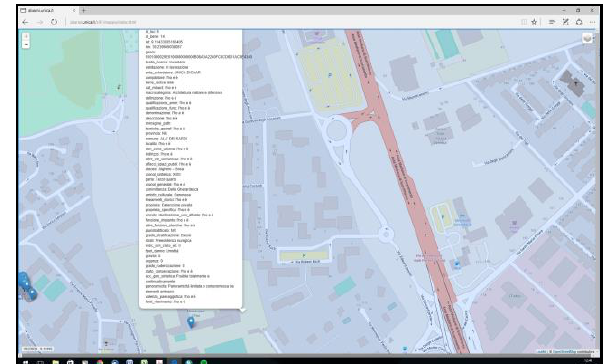
Figure 10. The WebGIS with Open Street Map